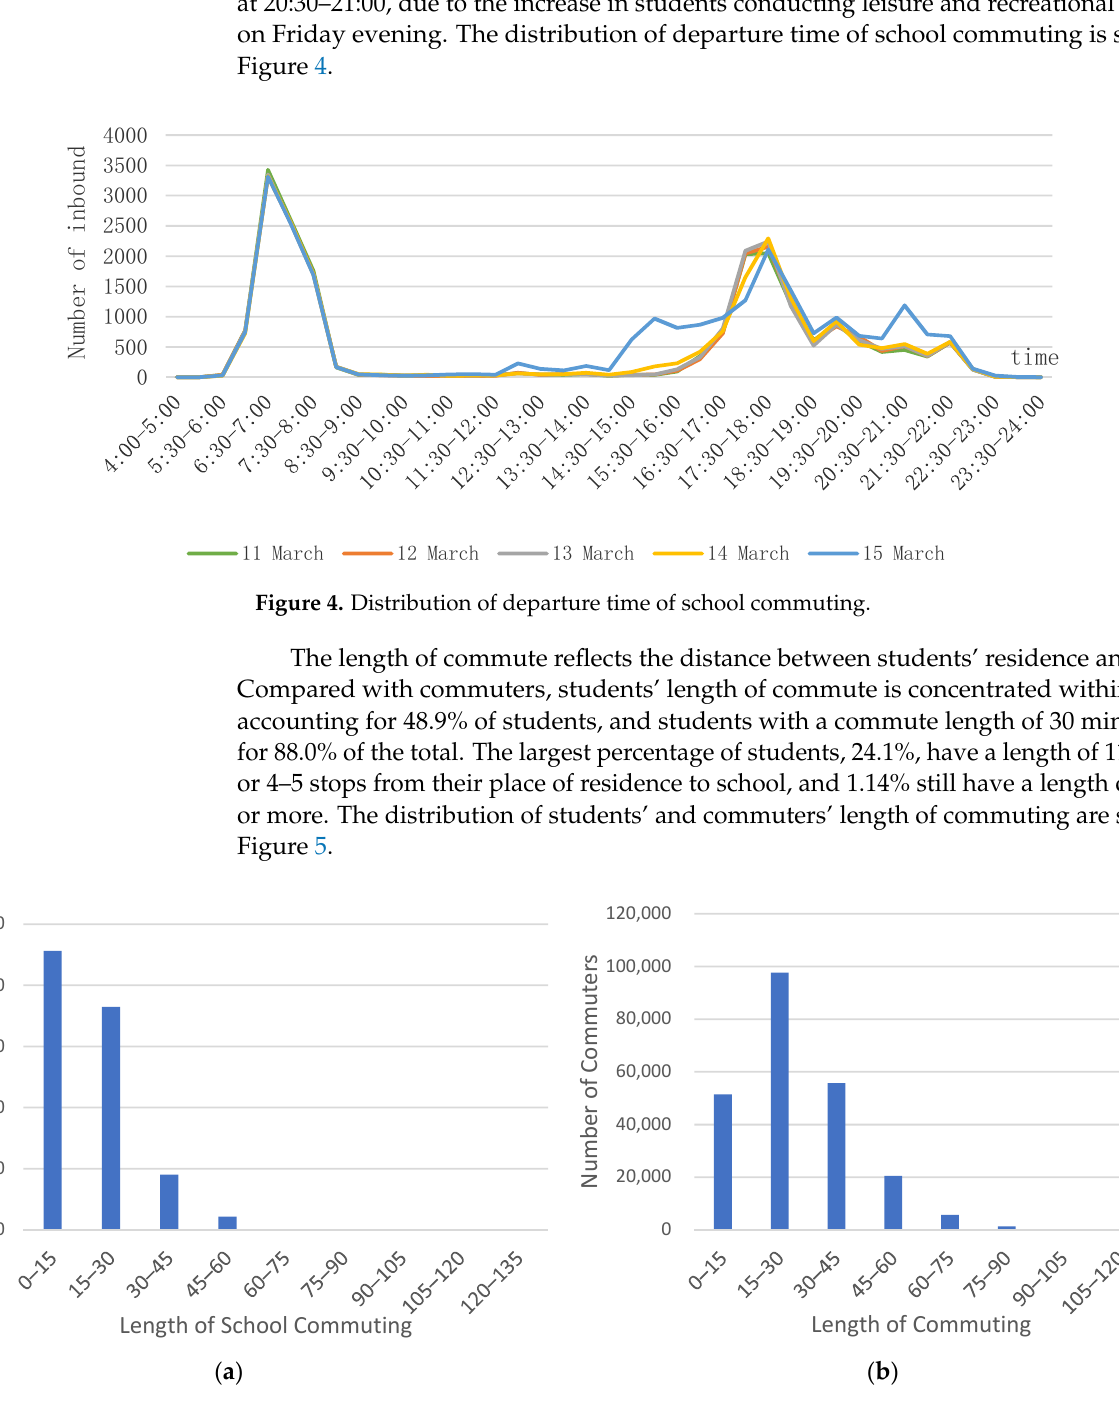
( b ) Figure 3. Traveling and commuting frequency. ( a ) Frequency of students traveling and commuting on school days; ( b ) Average number of school commuting as a percentage. 3.1.3. Travel Time